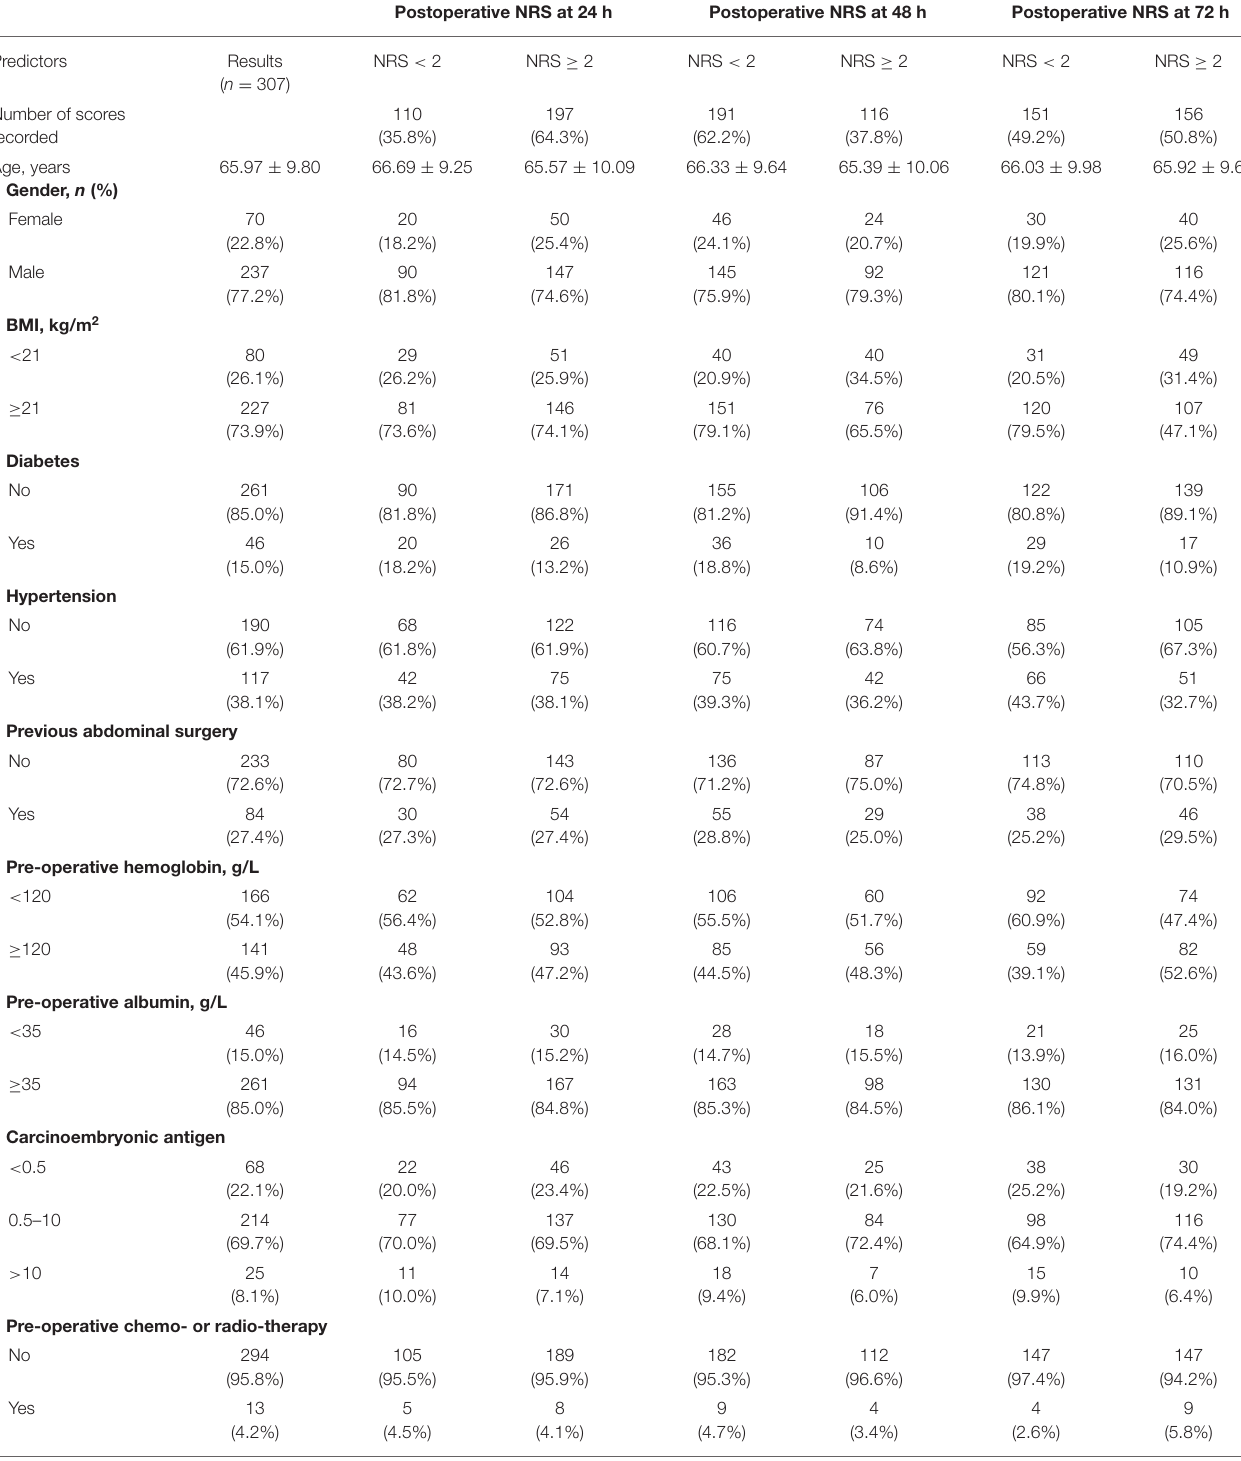
TABLE 1 | Patient